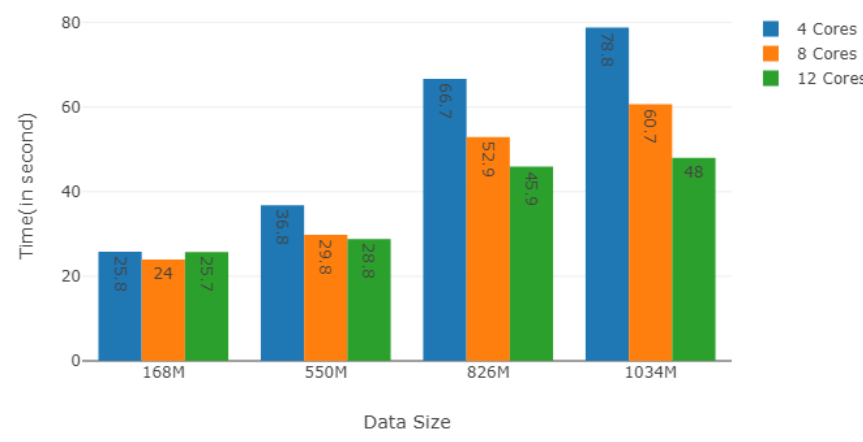
Figure 16. Spark computing performance under different CPU number.